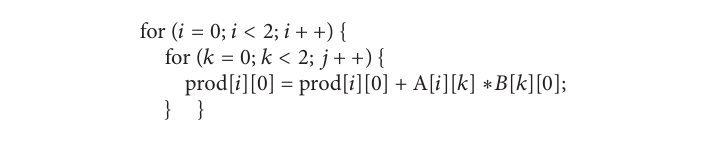
Algorithm 2: For-loop code for a matrix-vector